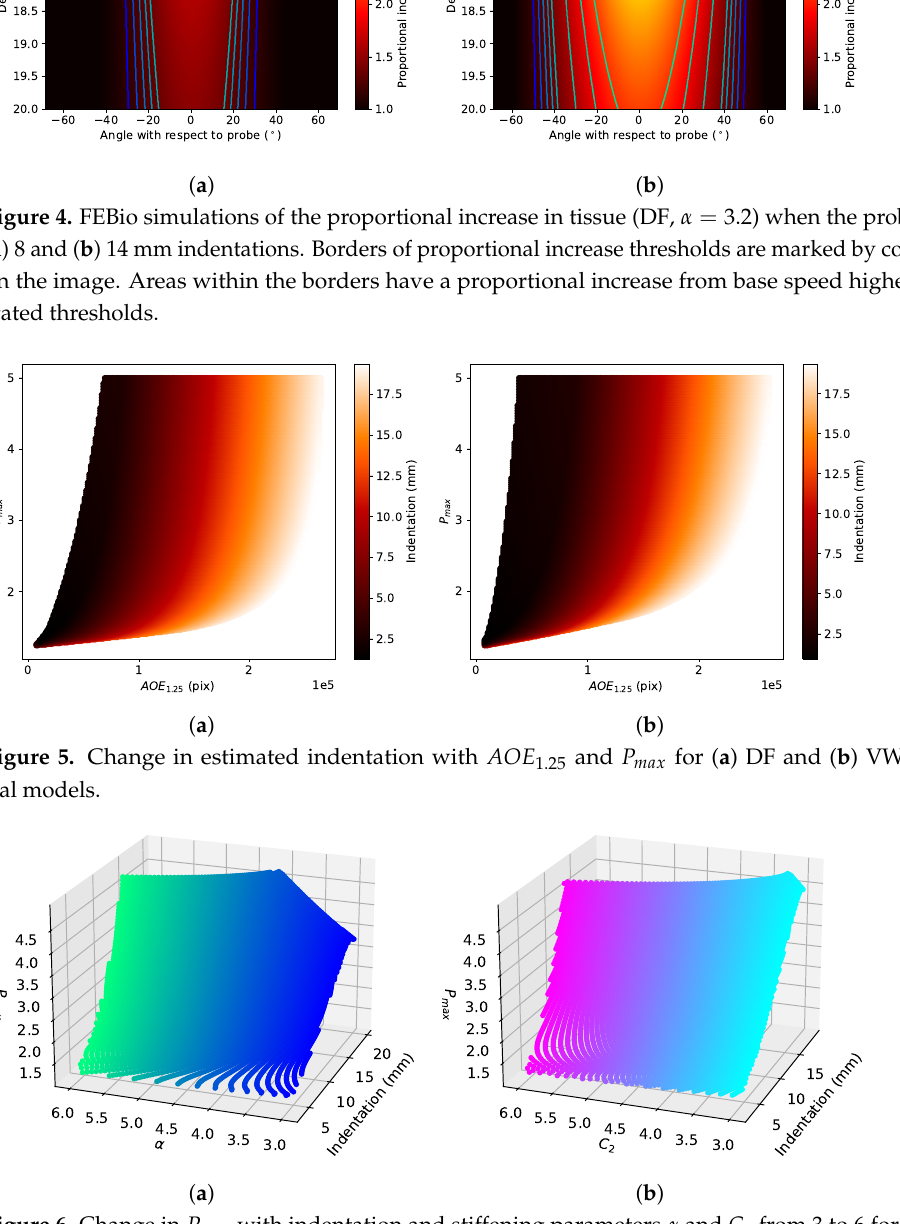
Figure 6. Change in P max with indentation and stiffening parameters α and C 2 from 3 to 6 for ( a ) DF and ( b ) VW material models,